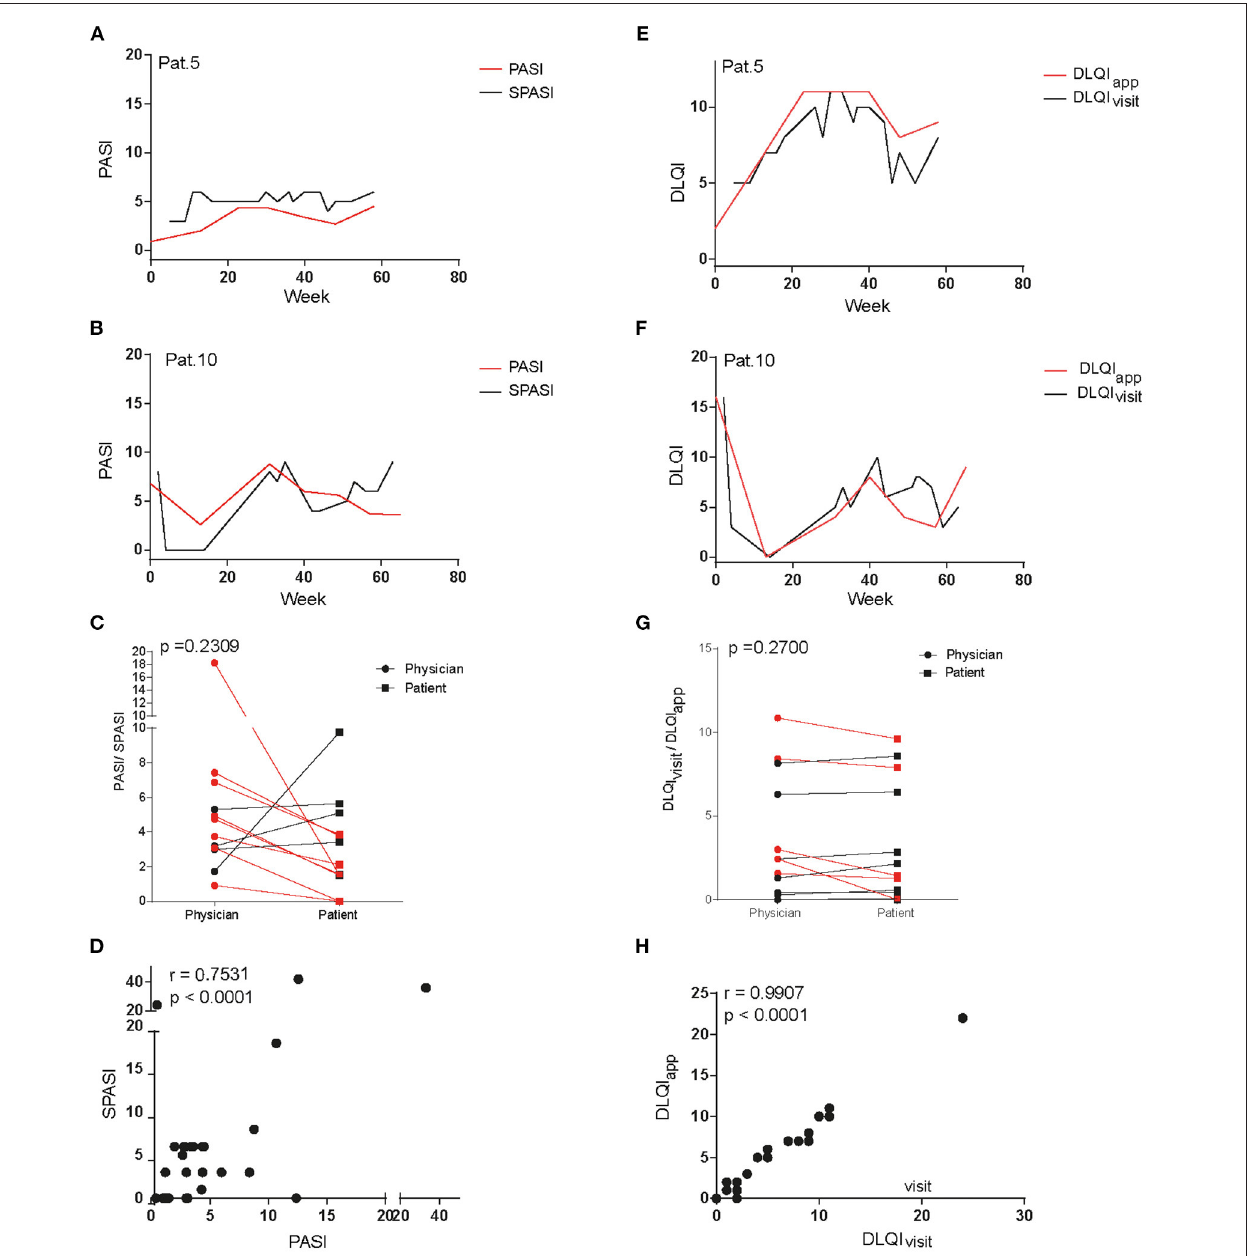
FIGURE 2 | Comparison of dermatology life quality index and disease severity assessed at outpatient visits and via app questionnaire. Curves of PASI and SPASI take a similar course as exemplarily shown for patients 5 (A) and 10 (B) . Comparison of mean PASI values as measured by physicians and mean SPASI values as measured by patients during the course of the study show no difference on patient level (C) . SPASI and PASI across patients show high correlation (D) . Also, curves of DLQI app and DLQI visit take a similar course in patients 5 (E) and 10 (F) . Mean DLQI visit values as stated during outpatient visits and mean DLQI app values as determined via app during the course of the study do not differ on patient level (G) . DLQI app and DLQI visit across patients show high correlation (H)